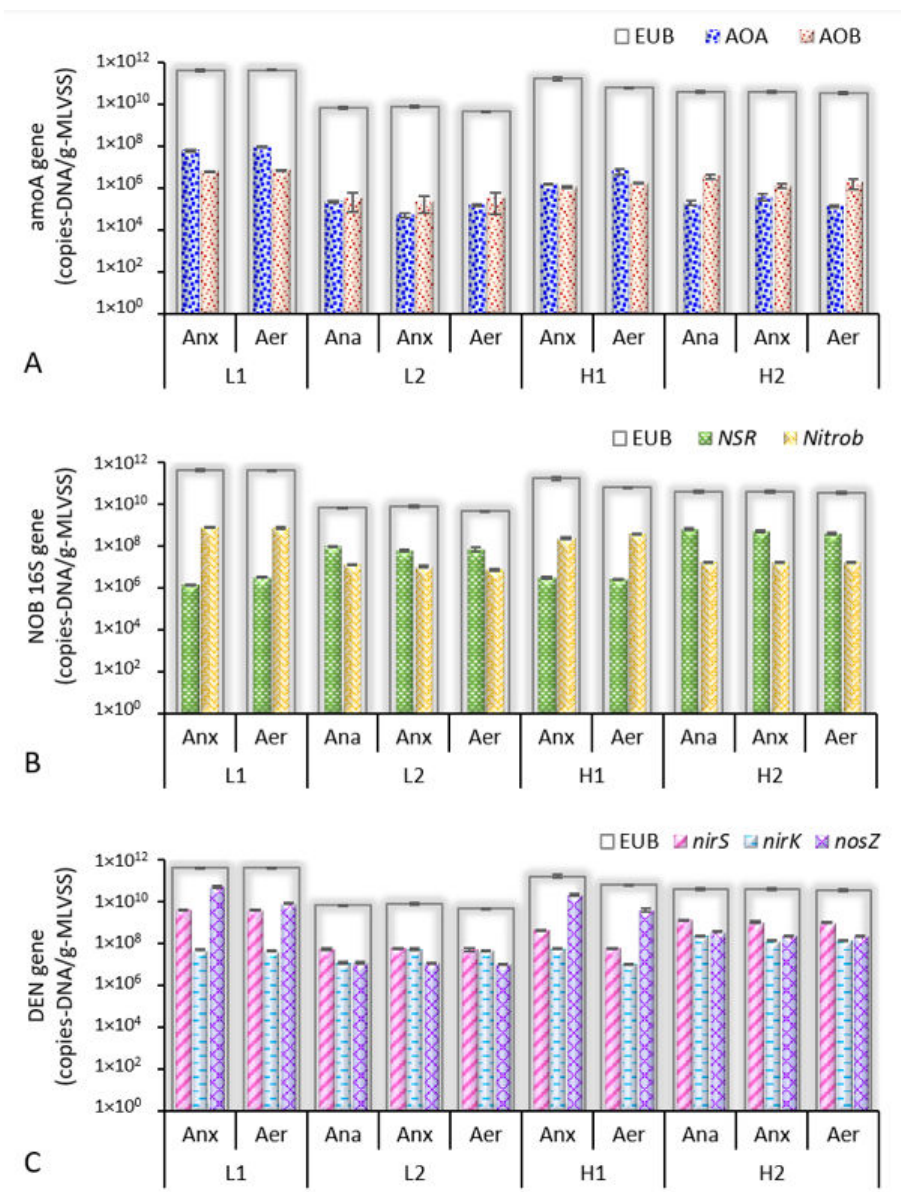
Figure 3. Microbial abundance of ( A ) amoA gene-AOA and -AOB, ( B ) NOB, and ( C ) DEN at L1, L2, H1, and